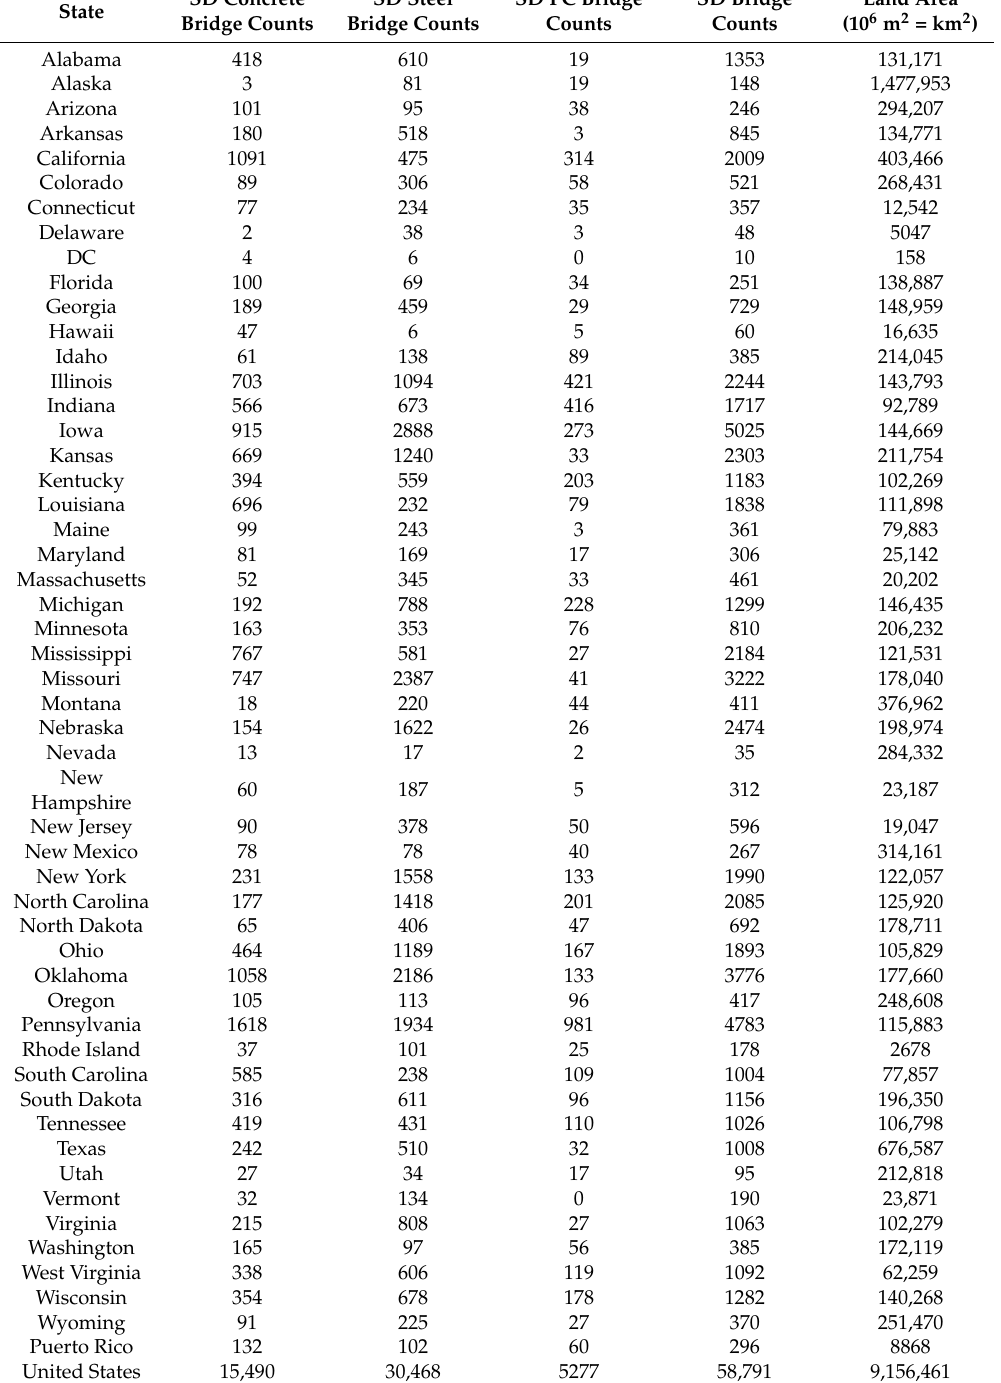
Table 2. Structural Deficiency of Bridge Materials by